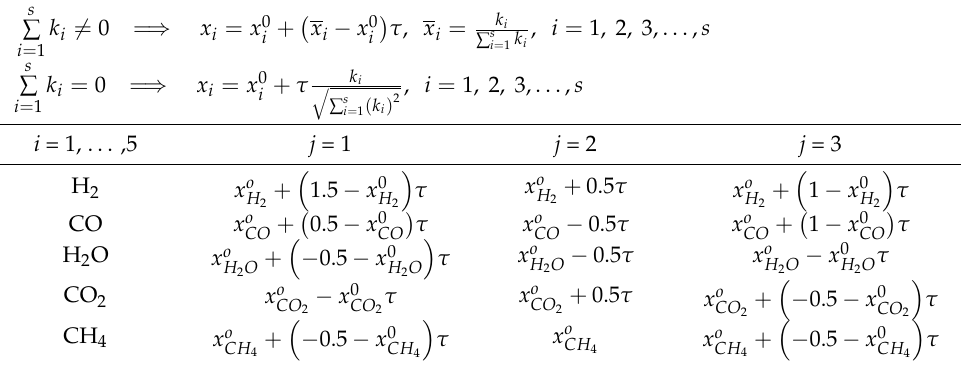
Table 2. Parametric equations for the equilibrium compositions of components ( i = 1, 2, 3, 4, 5) of